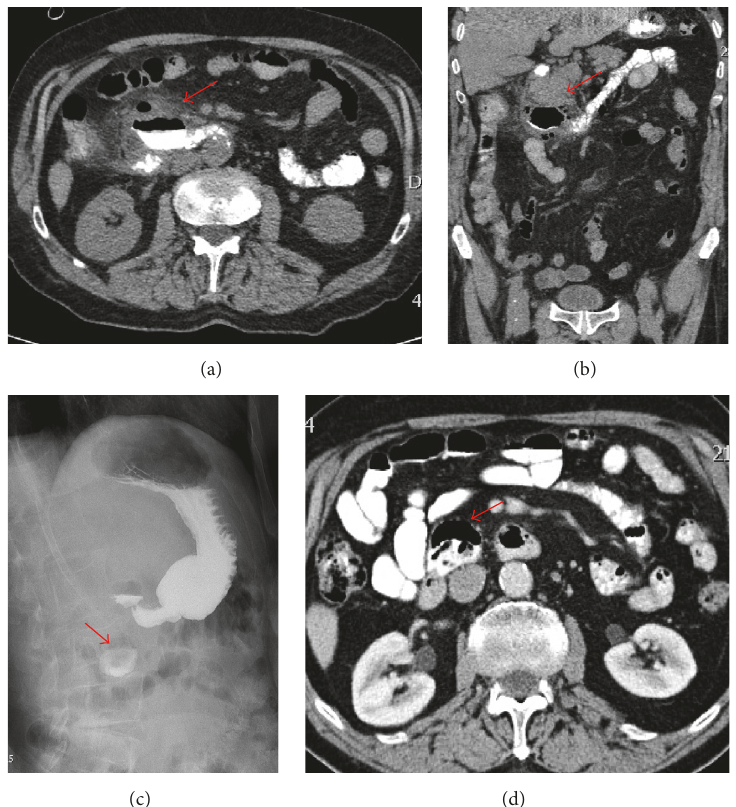
Figure 1: (a & b) Computed Tomography of the abdomen, with PO contrast, showing the evidence of a duodenal diverticulum with contrast extravasation, surrounded by fat stranding and air pockets (arrow), suggestive of perforation ((a) axial; (b) coronal). (c) Gastrografin swallow fluoroscopy, upon follow-up, showing the presence of contrast within the diverticulum (arrow) and absence of any extravasation. (d) Enhanced CT scan with IV and PO contrast showing the diverticulum with absence of extravasation and minimal air pocket with fat stranding